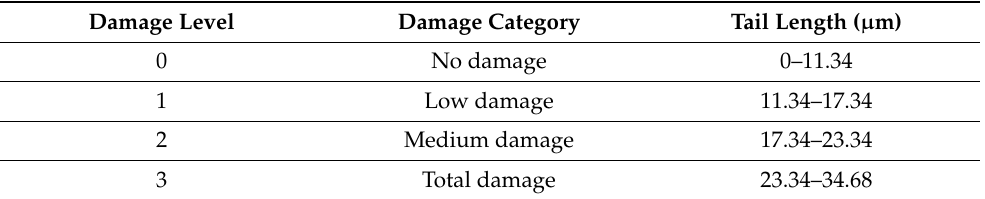
Table 1. Deoxyribonucleic acid (DNA) damage levels of cells exposed to different concentrations of polymeric photoresponse nanoparticles (PPNPs) and their precursors. Damage Level Damage